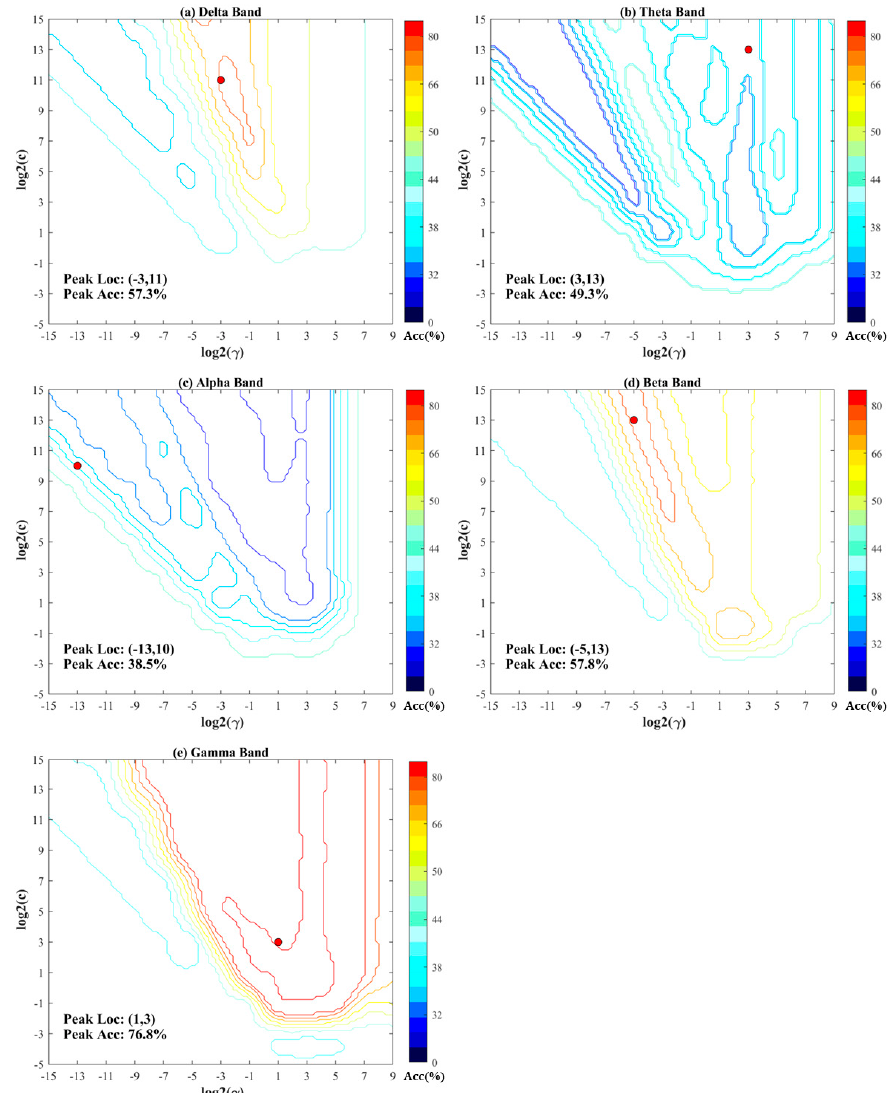
Figure 4. Grid search results of γ and C in the SVM-ML model with RBF kernel using the 21-channel EEG RSP features of the delta, theta, alpha, beta, and gamma bands. Acc: accuracy. Peak Acc: highest classification accuracy of the SVM-ML model in the predefined range of ( γ , C); Peak Loc: location ( γ , C) corresponding to the highest classification accuracy of the SVM-ML